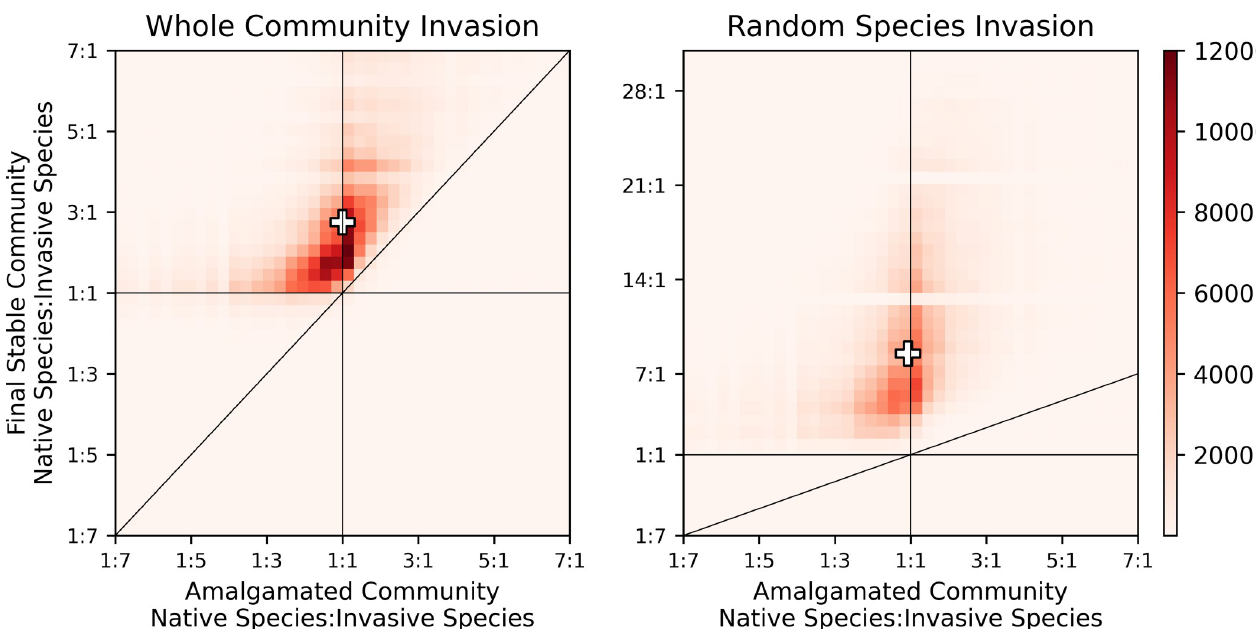
Fig 4. The symmetry between native and invasive species from the amalgamated community (horizontal axes) to the final stable community (vertical axes). Note the different ranges on the vertical axes to capture the long tail in the case of random species invasion. Thin black lines are included to guide the eye; the angled line indicates constant symmetry from the amalgamated community to the final stable community (i.e., it has a slope of 1). The “+” symbol indicates the median. For both whole community and random species invasion, the tendency is for final communities to become native dominant, though the effect is much less pronounced in the case of whole community